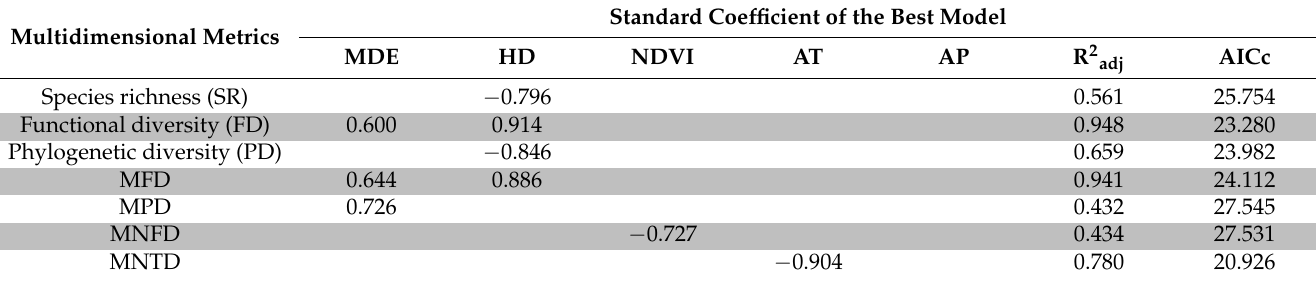
Table 2. Results of best model selection exploring associations between multiple biodiversity indices and five predictor variables along elevation gradients in Qingliang